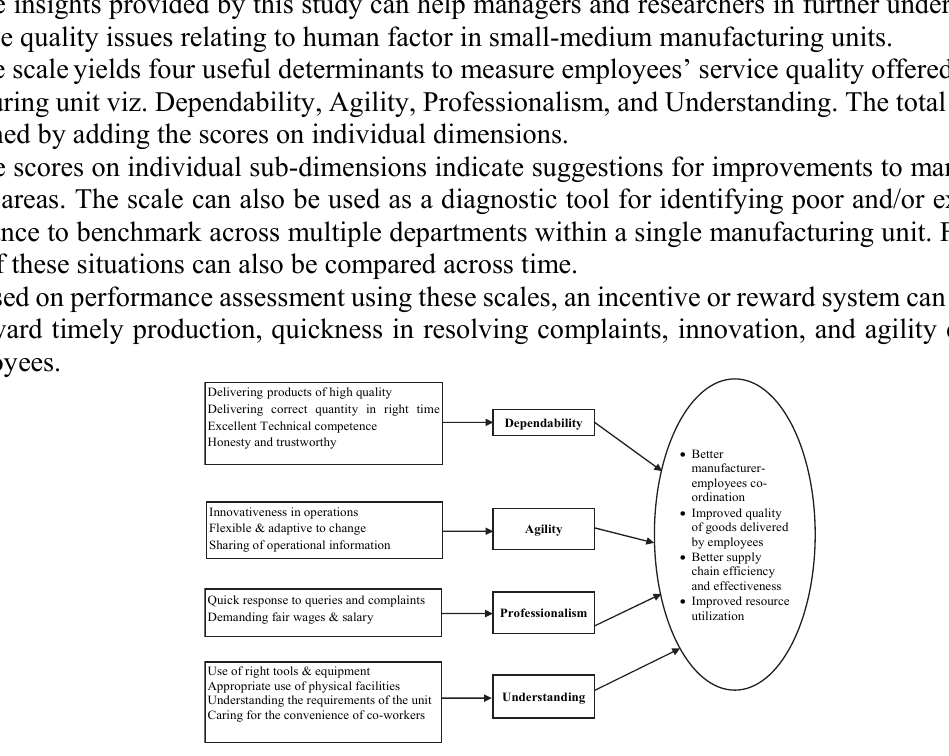
Fig. 5. Typical benefits of Employee service